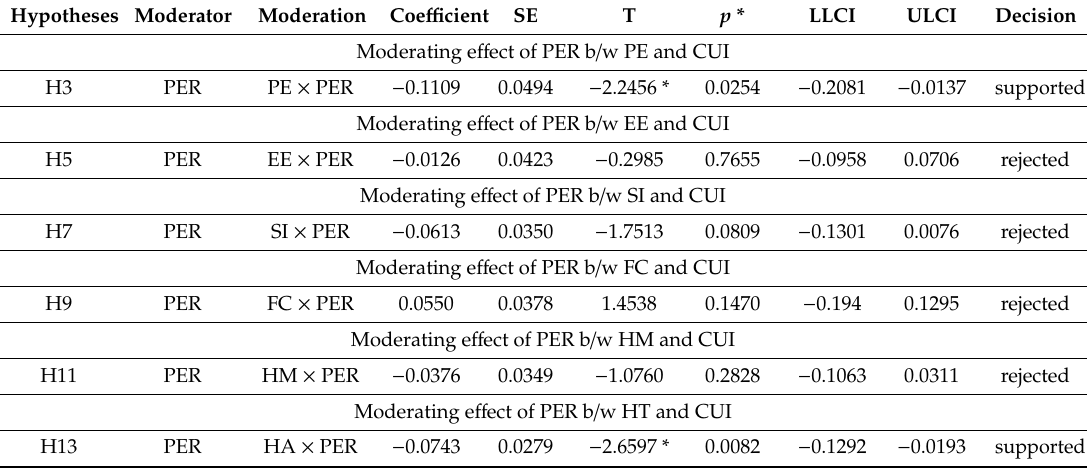
Table 5. Results of the moderating e ff ect of personalization on